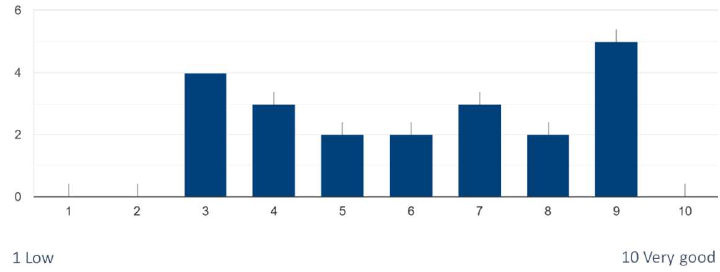
Figure 14: Evaluation of replacement possibility with simulator for the learning